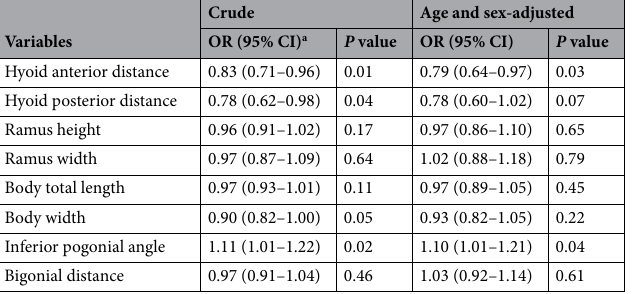
Table 3. Crude, and age and sex-adjusted logistic regression for the prediction of difficult airway. a Odds ratios (OR) and 95% confidence intervals